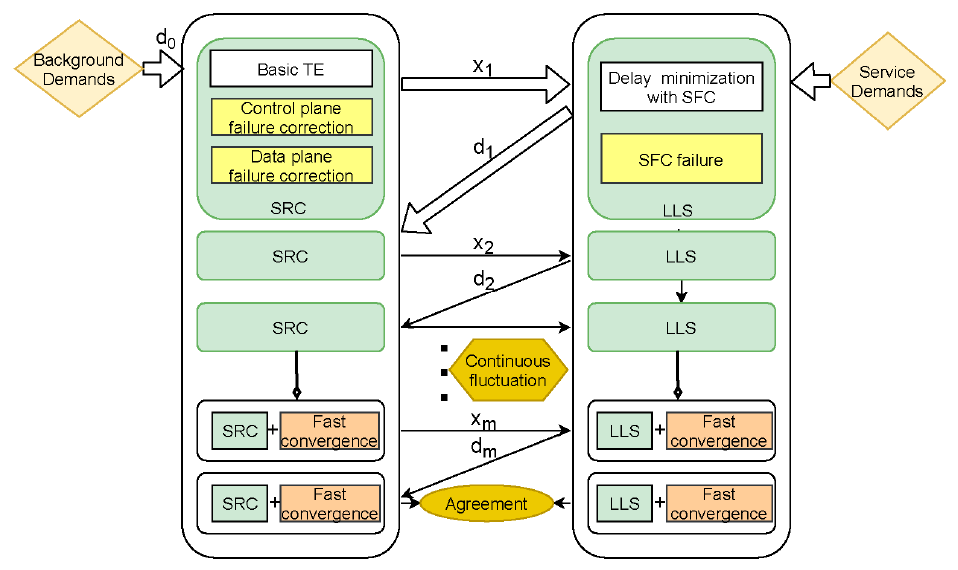
Figure 1. Multilayer architecture with LLS and SRC under failure scenarios. Different network error recovery mechanisms have different effects on the quality